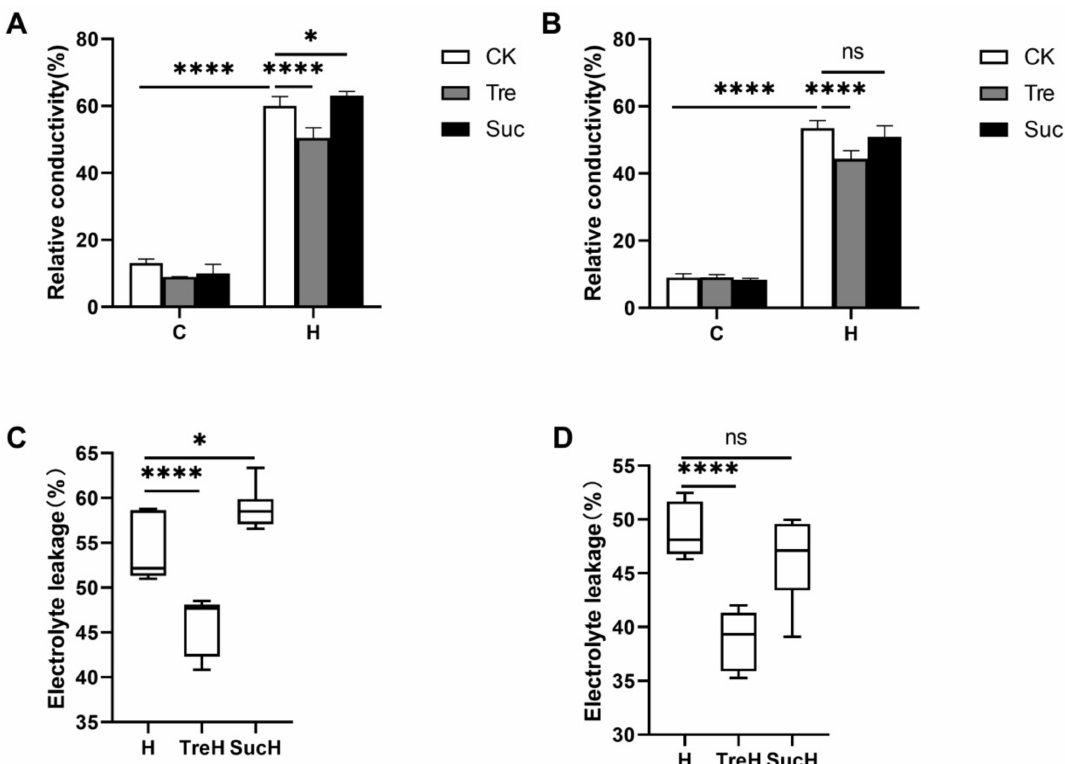
Figure 2. The relative electrical conductivity and electrolyte leakage of two varieties of wheat seedlings. ( A , B ) C—room temperature; H—high temperature; CK—control group; Tre—trehalose pretreatment group; Suc—sucrose pretreatment group; ( C , D ) H—high-temperature stress treatment for 24 h; TreH—trehalose pretreatment for 3 d followed by high temperature stress treatment for 24 h; SucH—sucrose pretreatment for 3 d followed by high temperature stress treatment for 24 h. ( A , C ) Yangmai 18. ( B , D ) Yannong 19. Values are the means ± SDs ( n = 3). * indicates a significant difference at 0.01 < p ≤ 0.05, **** indicates a significant difference at p ≤ 0.0001, ns indicates no statistical